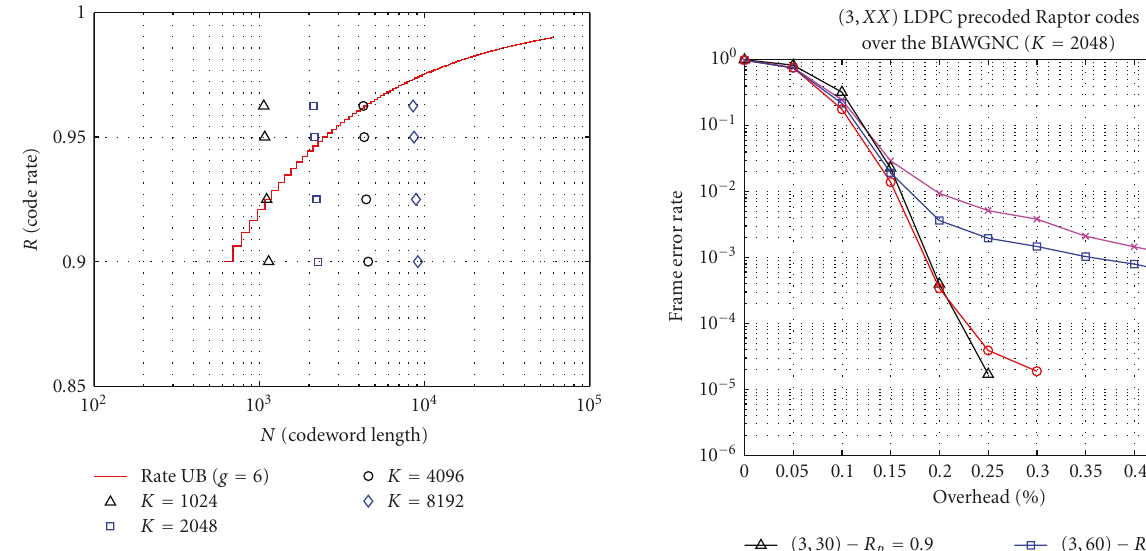
Figure 6: Upper bound on the code rate (Rate UB) such that a regular (3, d c ) LDPC code of girth 6 (no 4-cycles) and size N exists.